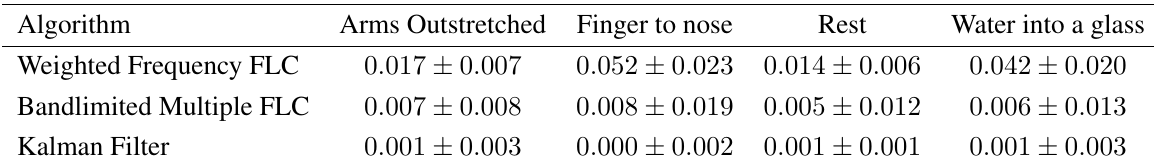
Table 3 . Filtered Mean Square Error with Delay correction (rad/s) for tremor estimation algorithms organized by task. Table provides mean (cid:6) standard